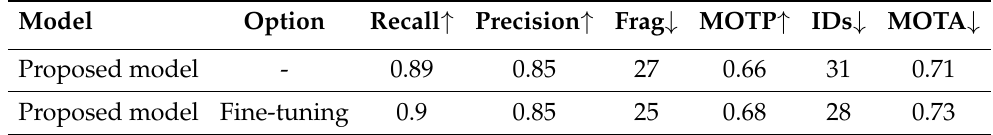
Table 4. Results of fine tuning. The arrows indicate better performance for each metric. (i.e., down arrow—lower is